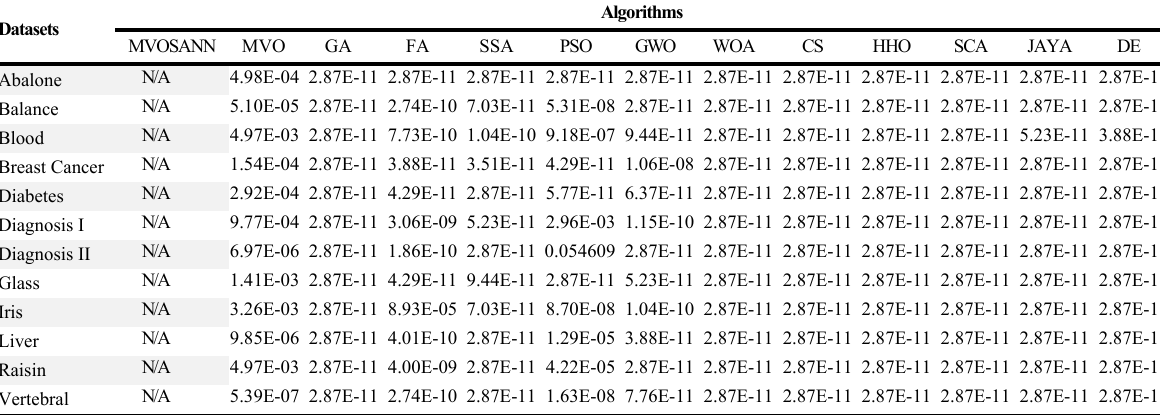
Wilcoxon rank sum test 𝑝 -values (N/A = not applicable)